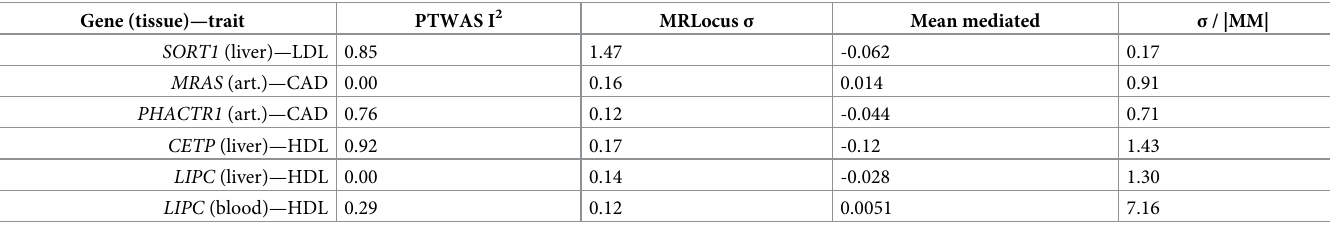
Table 1. I 2 statistic for PTWAS and dispersion estimate σ from MRLocus for eQTL-GWAS pairs. Gene (tissue)—trait